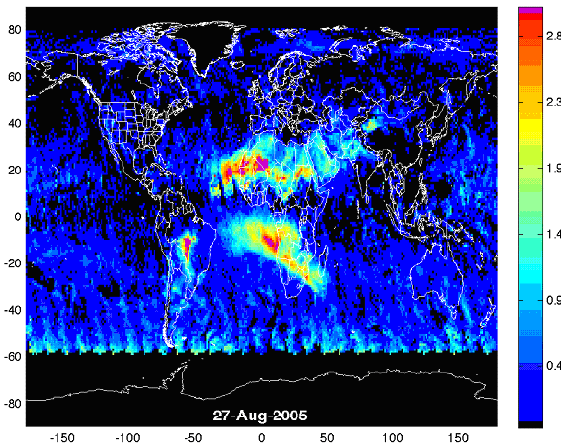
Figure 13. Fig. 13. 3-day averaged OMI aerosol index (AI) map showing dis- tinct regions of aerosol outflow from Africa towards South Amer- ica. The data were obtained from NASA/GSFC TOMS server (ftp://toms.gsfc.nasa.gov/pub/omi/data/aerosol/) processed in Mat- lab. Averaging of data was done to smoothen image quality.